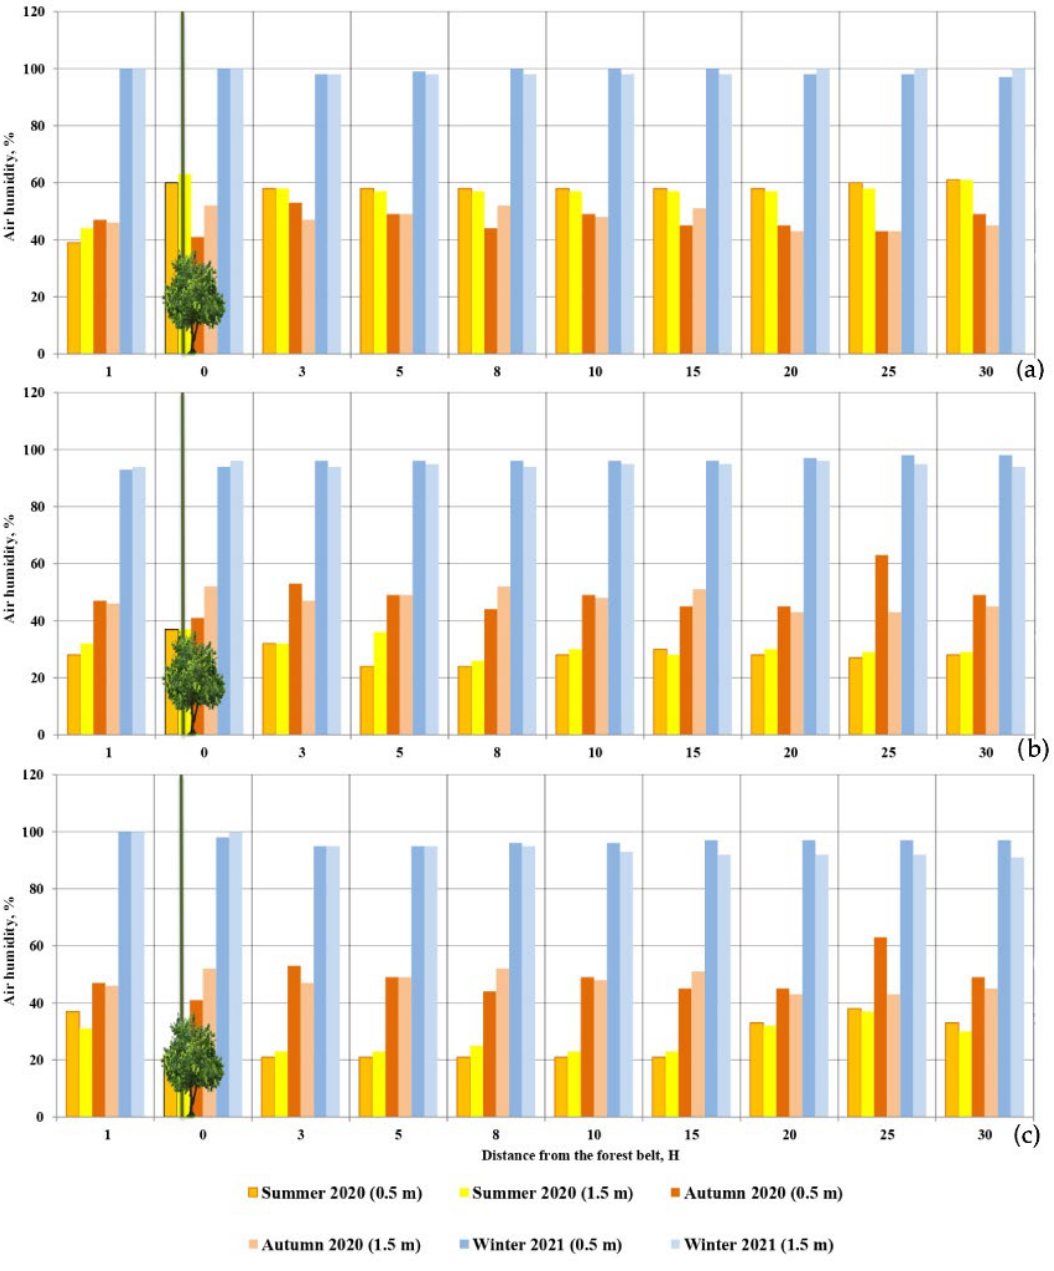
Figure 8. Air humidity in the agrolandscapes of the Kachalinskoe farm in 2020–2021: ( a ) 10 a.m., ( b ) ( b ) 1 p.m., ( c ) 4 1 p.m., ( c ) 4 p.m.